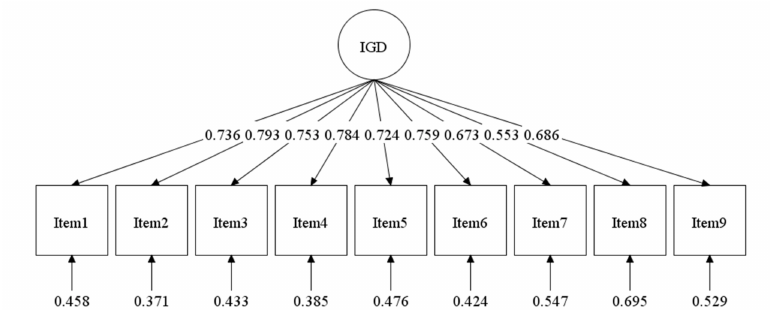
Figure 1. Path diagram with summary of the confirmatory factor analysis (CFA) obtained from the nine items of the Internet Gaming Disorder Scale-Short Form (IGDS9-SF). IGD: internet gaming